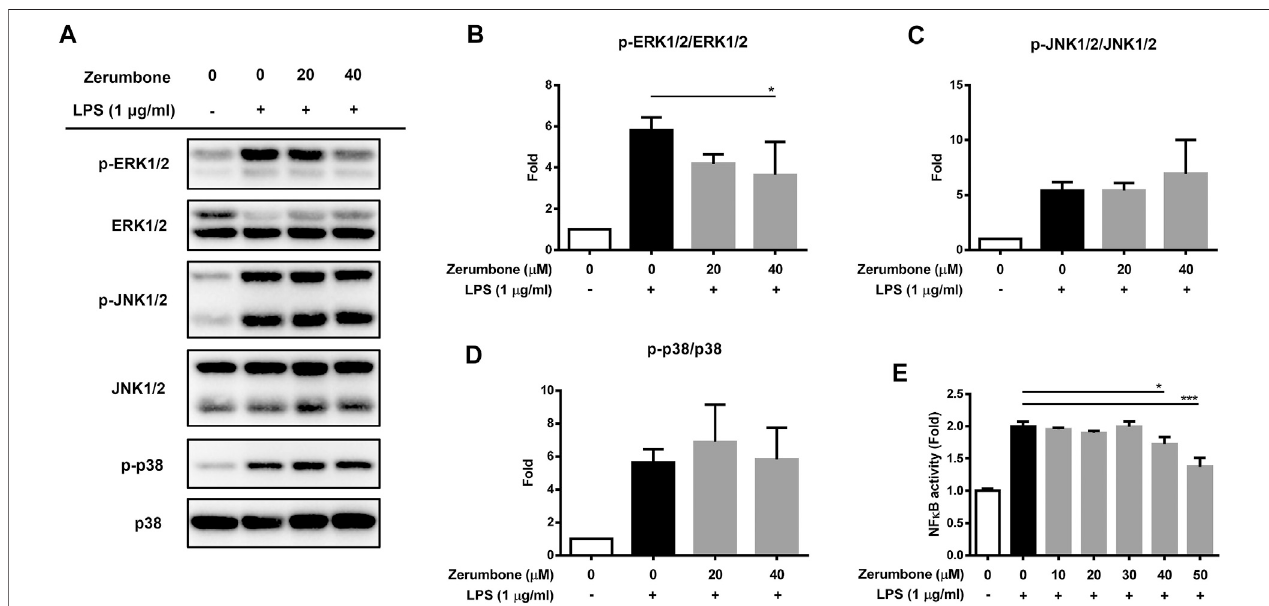
FIGURE 3 | The effects of zerumbone on the activation of MAPK and NF- κ B in LPS-activated J774A.1 cells. Cells were pre-treated with various doses of zerumbone for 1 h following treatment of LPS (1 μ g/ml) for 2 h. (A) The expressions of MAPK-associated proteins were determined by Western blot. Phospho-speci fi c signals were then normalized against the total level of the target protein, using that protein as its own internal loading control for maximum accuracy. The representative Westernblot results wereobtained inthree separate experiments. (B – D) Theintensities ofbandswere quanti fi ed from three separate experiments and normalized to untreated samples. Data were resented as means ± SD. (D) J-blue cells, a stable NF- κ B reporter cell line generated by transfected J774A.1 cells with NF- κ B SEAP report plasmids, were pre-treated with various doses of zerumbone for 1 h following treatment ofLPS (1 μ g/ml) for 6 h. The activation of NF- κ B was examined by SEAP activity. Data were represented as means ± SD. Statistical signi fi cance between the zerumbone-treated groups vs. the LPS-only group is represented as follows: * p < 0.05, ** p < 0.01 and *** p < 0.001.